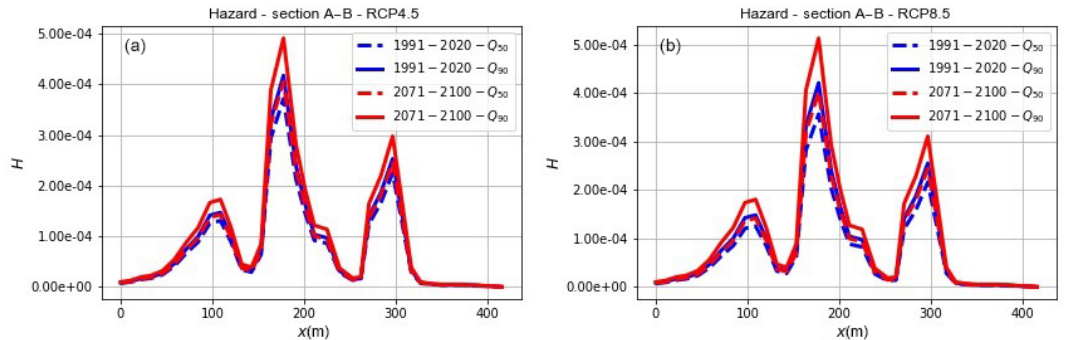
Figure 14. Landslide hazard for section A–B, calculated for time intervals 1991–2020 and 2071–2100 and for quantiles Q 50 and Q 90 : (a) RCP4.5 and (b)